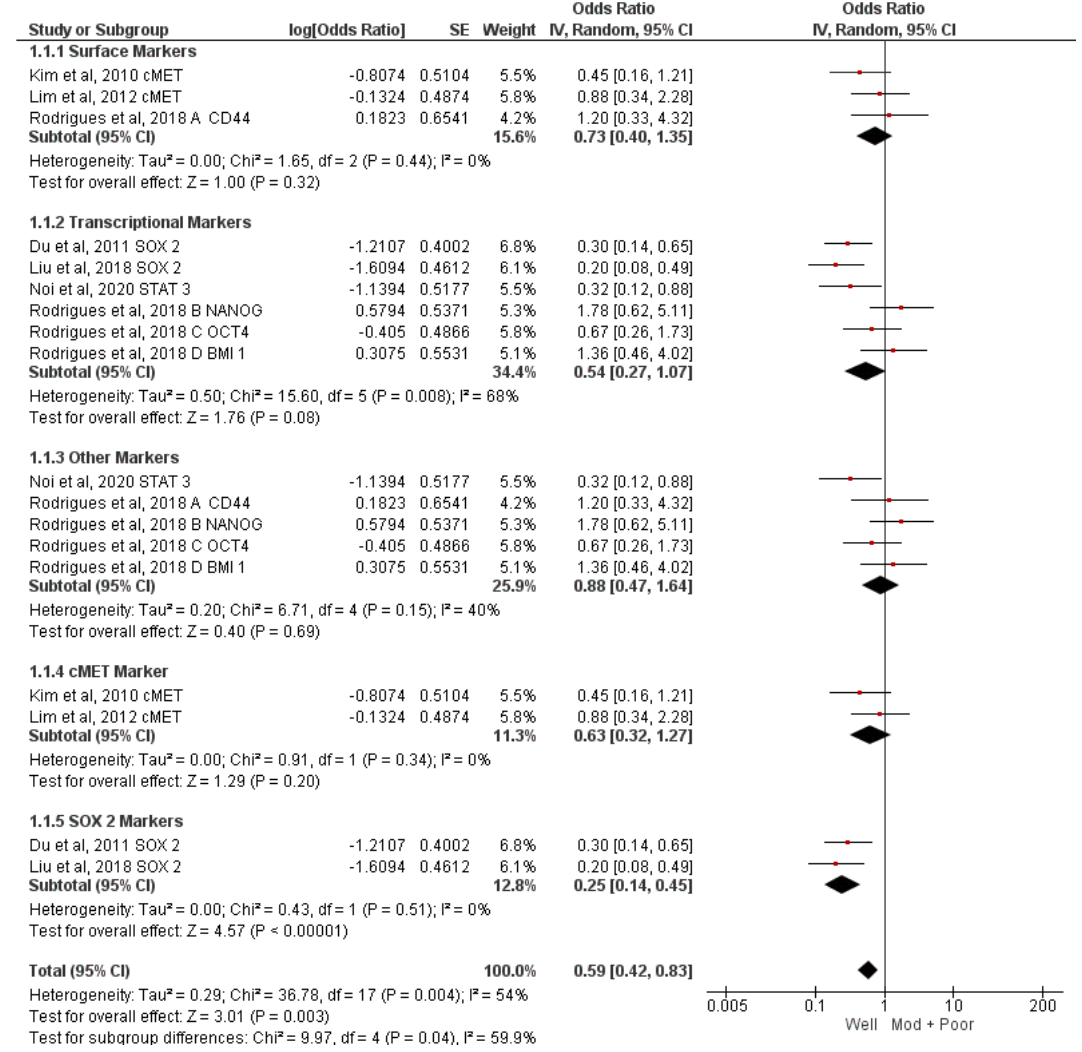
Figure 2. Meta − analysis of CSC markers and tumor stage